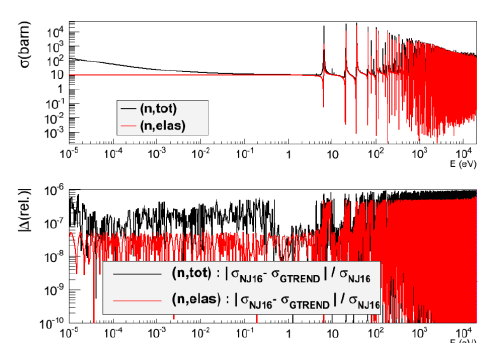
Fig. 2. Comparison between NJOY2016 and GTREND on U238 reconstruction in